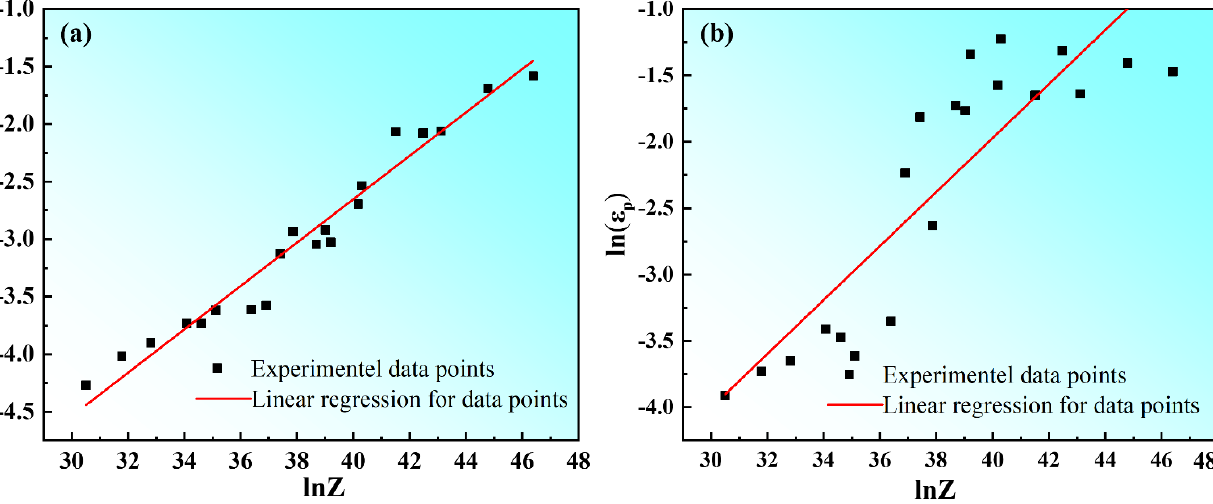
Figure 5. Relationship between critical strain ( ε c ) and Zener – Hollomon parameters (Z-parameter) (a) , and correlation between peak strain ( ε p ) and Zener – Hollomon parameters (Z-parameter) (b) .